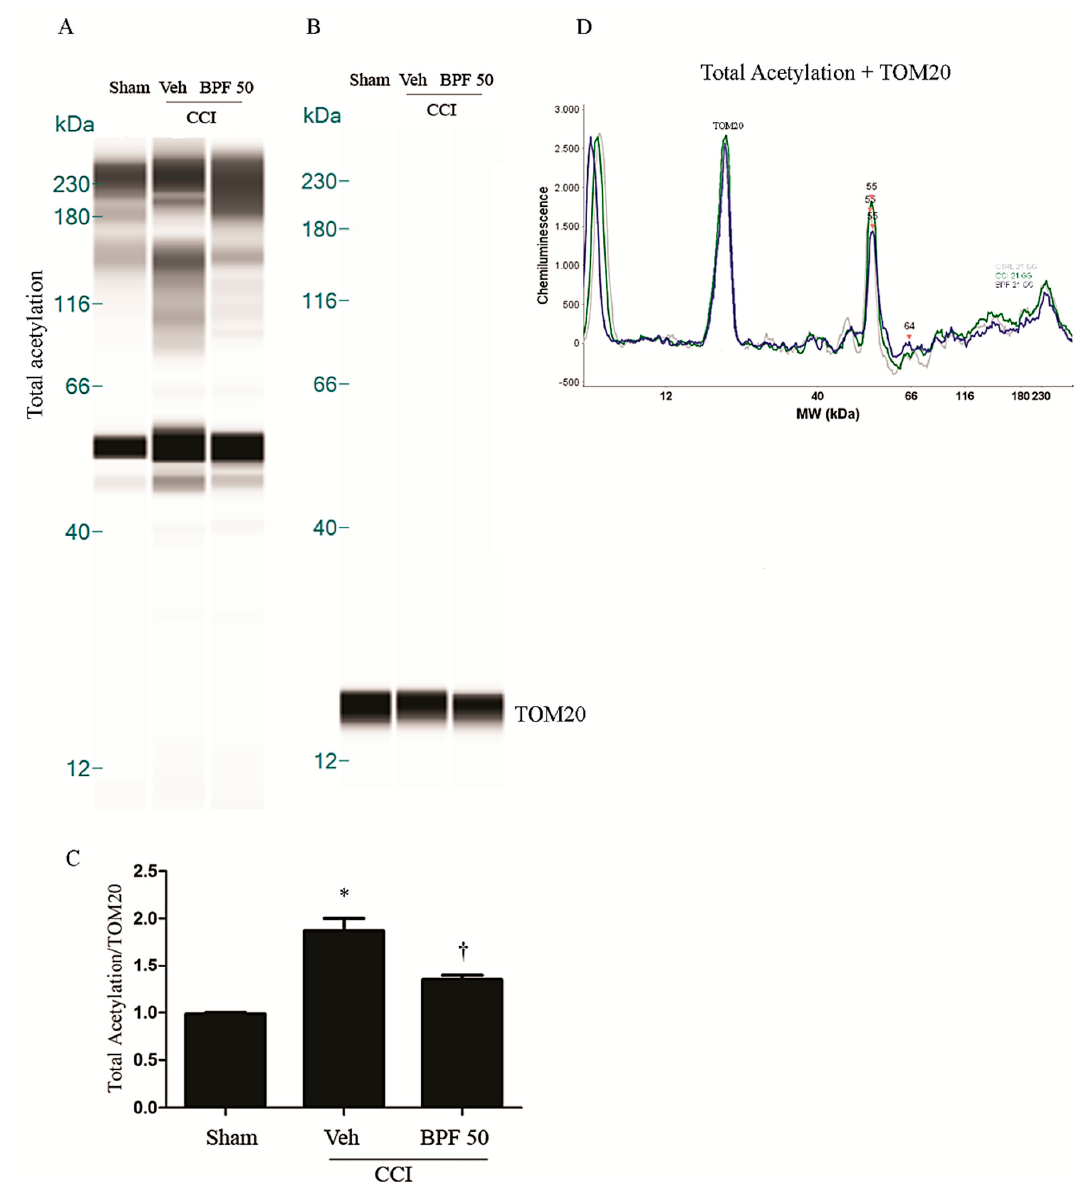
Figure 9. The inhibition of SIRT3 induces acetylation on mitochondrial proteins 21 days post injury. ( A ) Inactivation of SIRT3 led to significant acetylation of mitochondrial proteins either 21 days post injury as shown by WES methodology. Subcutaneous infusion of BPF (50 mg / kg), concurrently with surgery (day 0), prevented mitochondrial proteins acetylation. ( B ) No di ff erence for TOM20 expression was detected among the lanes in these conditions. ( A , B ) Lanes and ( D ) electropherogram are representative of results from 6 animals. ( C ) Densitometric analyses of all animals per groups are reported. Results are expressed as mean ± SEM for 6 rats. * p < 0.05 versus sham; † p < 0.05 versus vehicle + CCI.